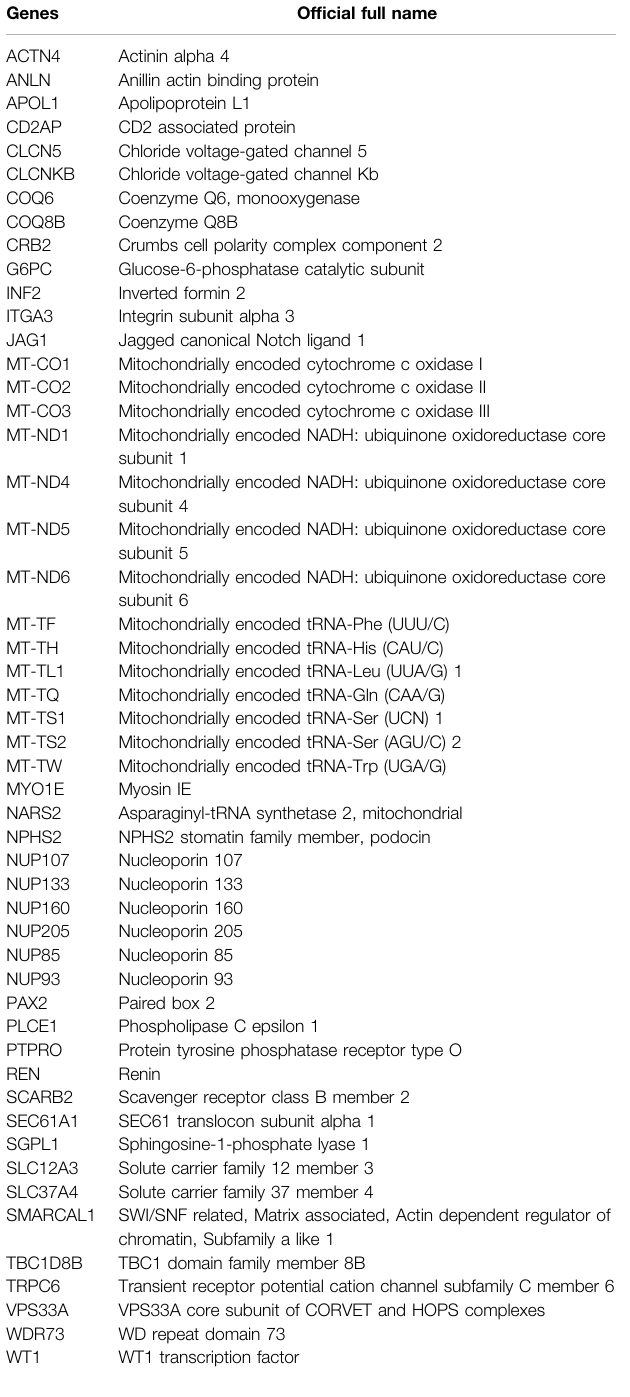
TABLE 2 | Fifty-one human genes related to the etiology and prognosis of FSGS. Genes Of fi cial full